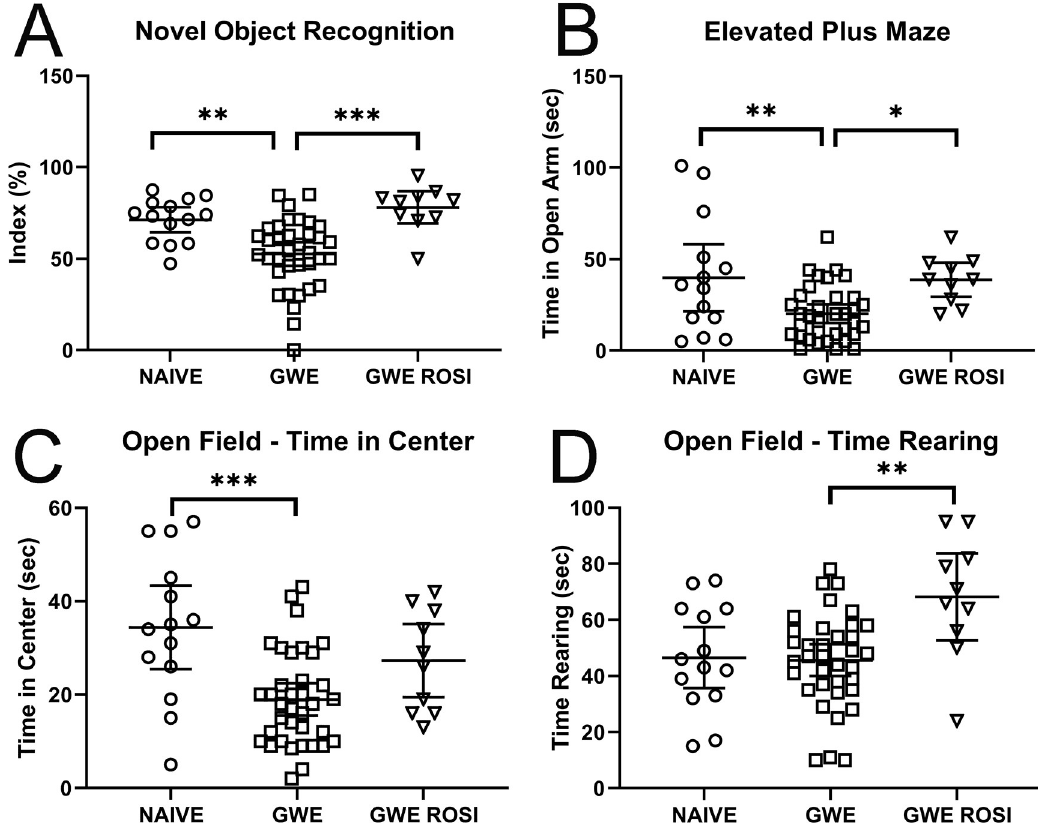
Fig 3. Neurofunctional tests for cognition and anxiety-like behaviors. � , p < 0.05; �� , p < 0.01; ��� , p <